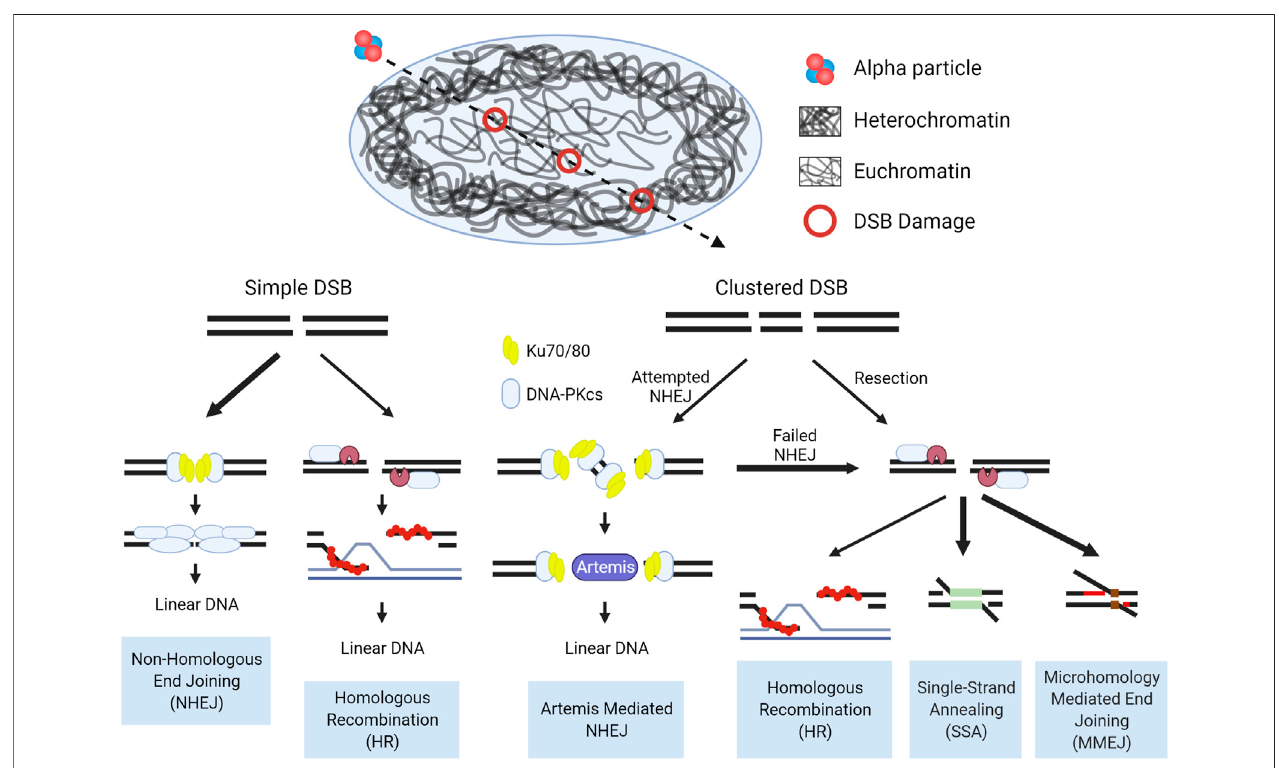
FIGURE 7 | Schematic of DSB repair pathway choice for high-LET induced damage in the context of chromatin. In the repair of simple euchromatic DSBs NHEJ functionsasthepredominant repair pathway, withaportion ofrepair carried outbyArtemismediatedNHEJ (G0/G1)or HR(S/G2).InitiationofNHEJatsites ofclustered damage is attempted, but due to the presence of short fragments which inhibit activation of DNA-PKcs, pathway choice shifts to resection mediated pathways. Hence, alternative, more error prone pathways are considered the major repair mechanism for high-LET induced clustered DSBs, but a more detailed mechanism for pathwaychoiceinachromatincontextisstilluncertain.Boldedarrowsdenotethe ‘ preferred ’ pathwayforrepair.Detailedpathwayschematicscanbefoundin Figure6 .